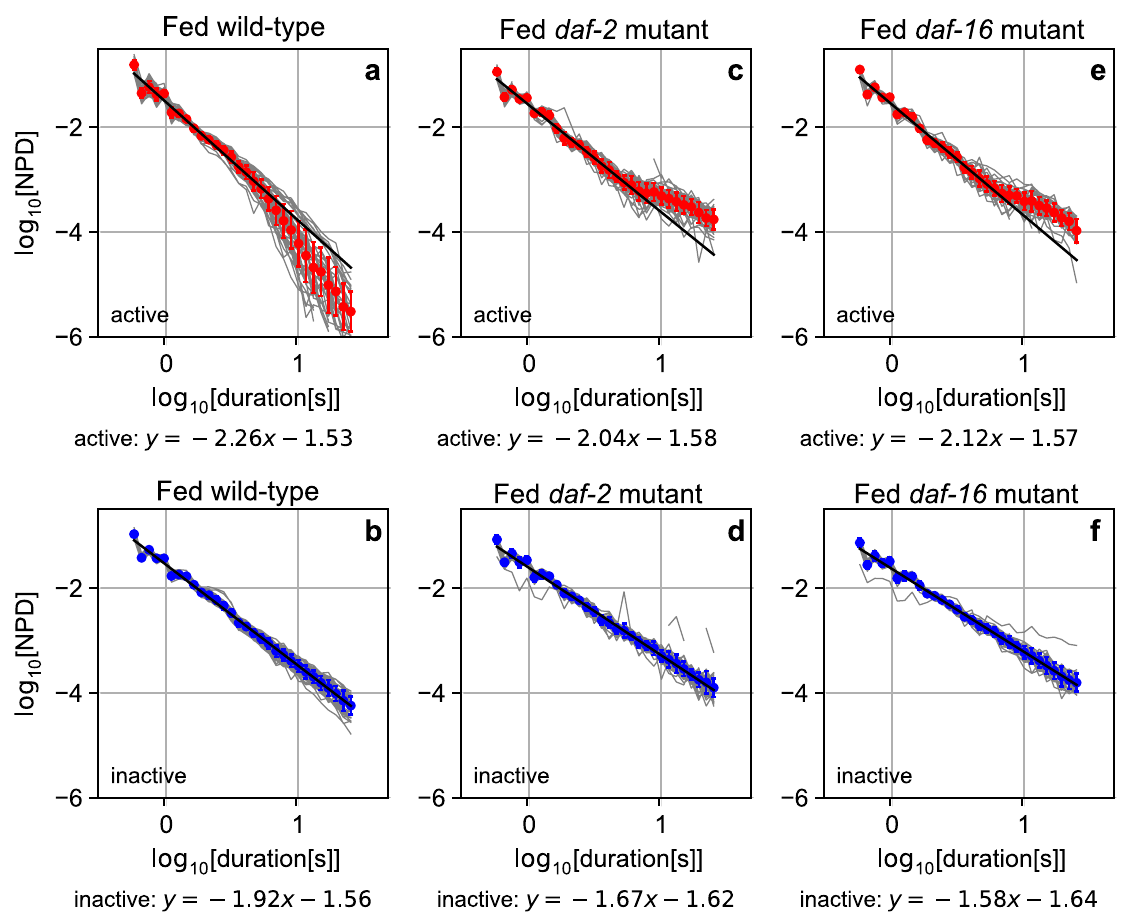
Figure 2. Power-law residence-time distributions of behavioral states of fed C. elegans Averaged normalized probability density distributions of active (red) and inactive states (blue) of fed wild-type ( a , b ), daf-2 ( c , d ), and daf-16 ( e , f ) animals among individual animals (grey), in log–log plot. Error bars represent standard deviations. Distributions for inactive state ( b , d , f ) were fit with linear function in the entire range in the residence time from − 0.5 to 1.5 on x-axis (black line). To visually track the presence of the exponential-like tail in the residence distributions for the active state ( a , c , e ), the distributions were fit with a linear function in the shorter range in the residence time from − 0.5 to 0.8 and were extrapolated to 1.5 on x-axis (black